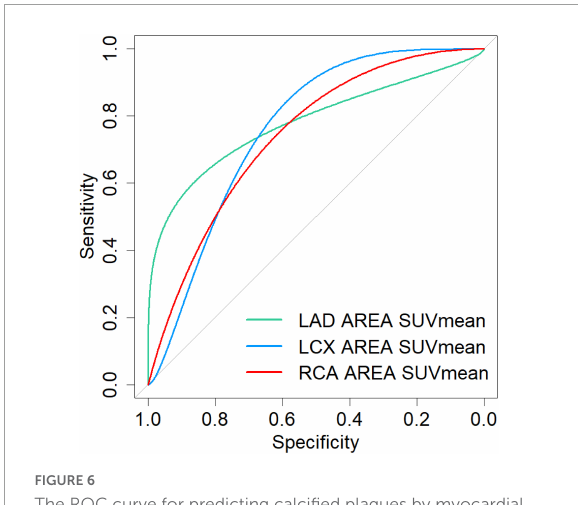
FIGURE6 The ROC curve for predicting calcified plaques by myocardial FAPI uptake (SUV mean ) in LAD, LCX, and RCA territory showed areas under the curve (AUCs) were 0.786 (95%CI: 0.581–0.99), 0.759 (95%CI: 0.521–0.998), and 0.769 (95%CI: 0.559–0.978), respectively.